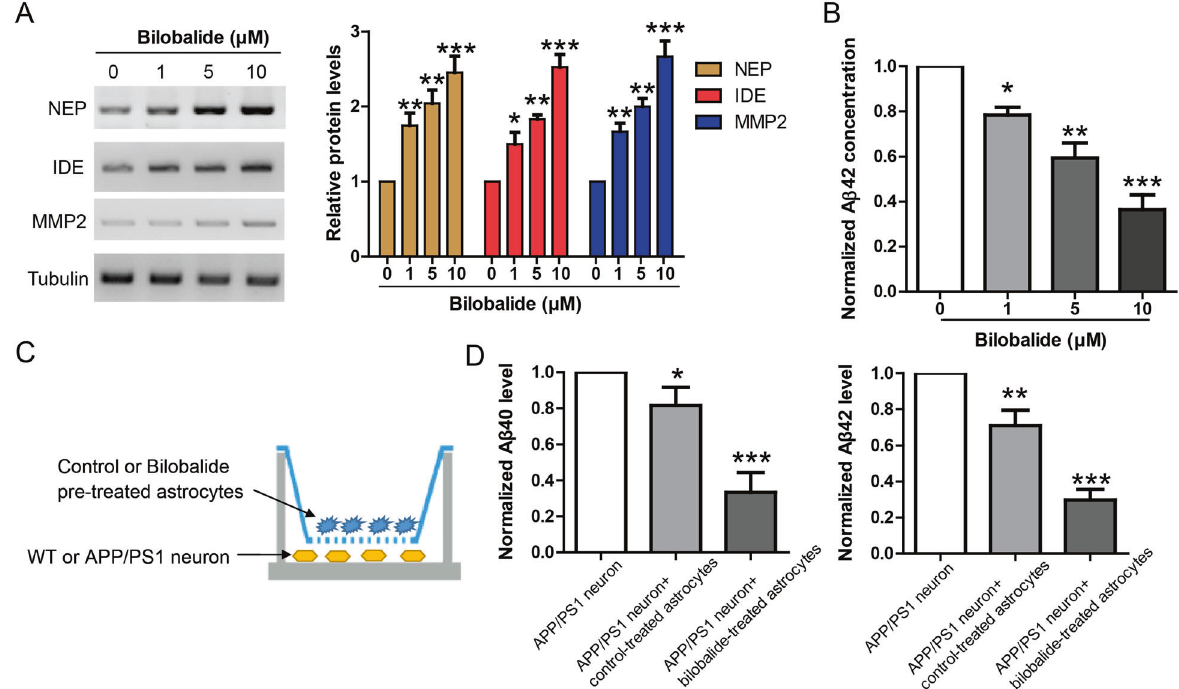
Fig. 3 Bilobalide induces the expression of A β degrading enzymes to facilitate A β clearance in primary astrocyte culture. A Western blot and its quanti fi cation showing the protein levels of NEP, IDE, and MMP2 in astrocyte culture treated by bilobalide at indicated concentrations. B A β clearance assay showing A β 42 levels in the culture medium of astrocytes treated by bilobalide at indicated concentrations. C Diagram showing the astrocyte-neuron co-culture in transwell system. D ELISA results showing A β 40 and A β 42 levels in the culture medium of APP/PS1 neuron co-cultured with control or bilobalide (5 μ M) pretreated astrocytes. * P < 0.05, ** P < 0.01, *** P < 0.001.